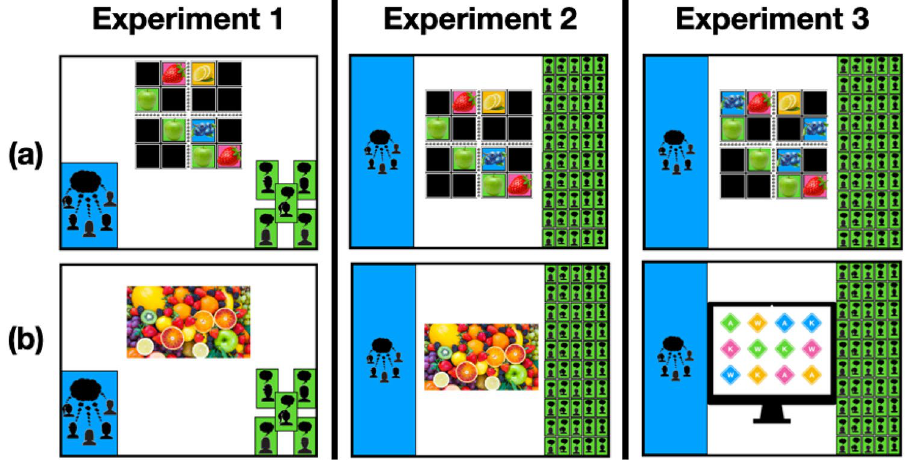
Figure 1. Example stimuli: Groups and Crowds. Each participant saw 8 questions. Experiments 1 and 2 used the same questions (4 Reasoning , 4 Population Preference ). Experiment 3 contrasted Easy versions of the Reasoning questions with Hard Perceptual Discrimination questions. ( a ) Top Row: Example Reasoning question. Two-by-two Fruit Sudoku from Experiments 1 & 2 & partially completed “Easy” version in Experiment 3. ( b ) Bottom Row: Example Population Preference question (most popular fruit in the world) and Perceptual Discrimination question (which shape is spinning the